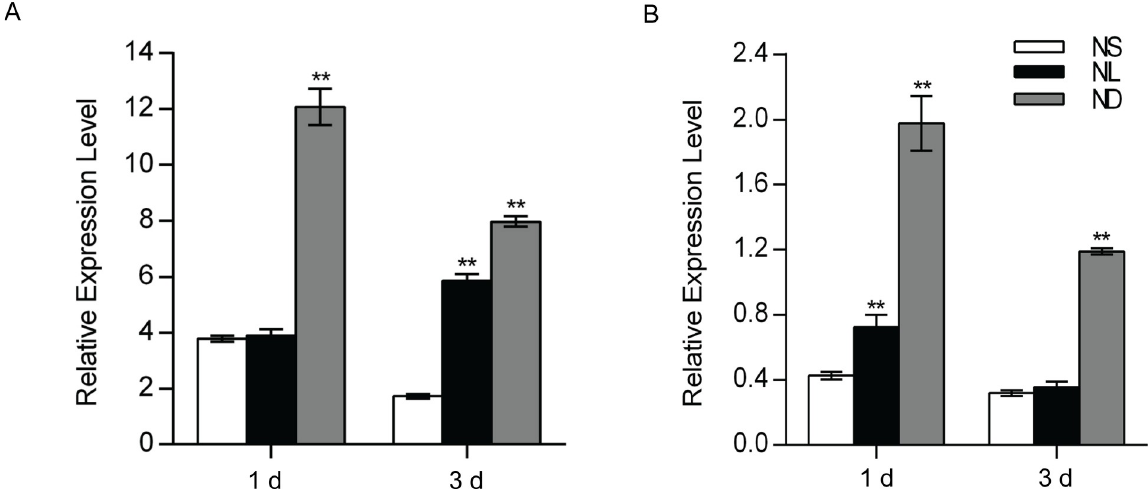
Fig 1. Identification of OsATG8b as a N deficiency inducible gene of rice by real-time RT-PCR. The rice seeds were sterilized and germinated at 28˚C for 2 d, then seedlings cultured with half Hoagland’s N-sufficient solution for 14 days, and transferred to the same N-sufficient (NS, 3.5 mM N) solution as the control, low N (NL, 0.8 mM N) solution and the N-free (ND, 0 mM N) solution for 1 d and 3 d. (A) The expression of OsATG8b gene in leaves. (B) The expression of OsATG8b gene in roots. OsActin1 was used as an internal control. Values are means ± SD of three biological replicates, � P < 0.05, �� P < 0.01 (t-test).